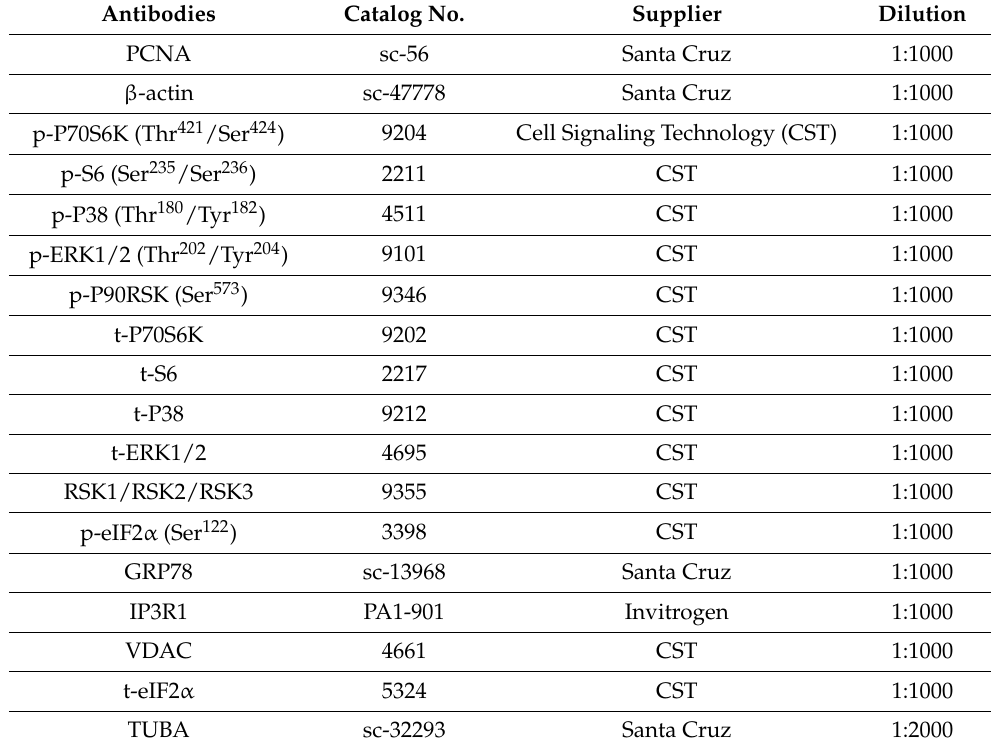
Table 1. Antibodies used in immunoblotting assays. Antibodies Catalog